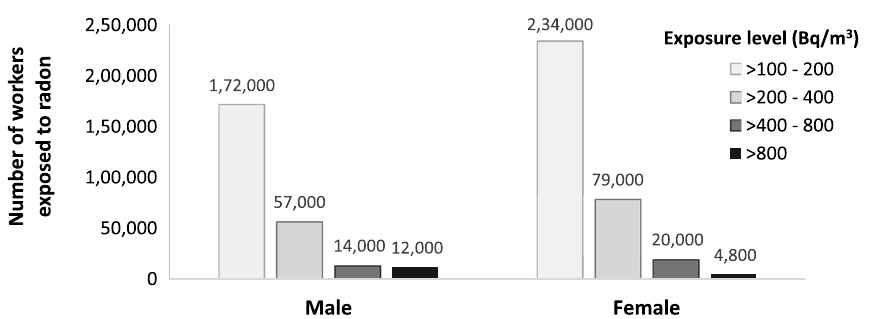
Figure 1. Estimated number of workers exposed to radon by sex and level of